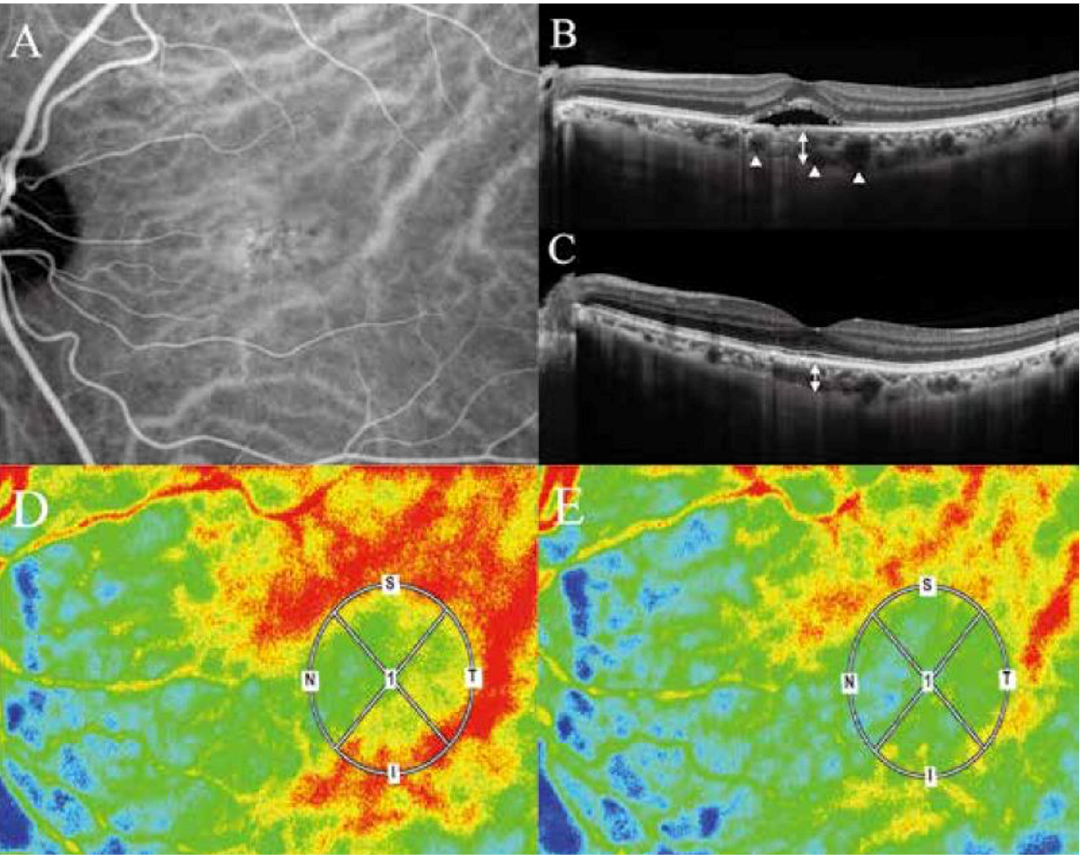
Figure 2. Photographs of an eye with CSC. ( A ). Indocyanine green dye leakage at the macula region shows hyperpermeability of the choriocapillaris. ( B ). CSC, pachychoroid, and pachyveins during the onset. ( C ). Regression of CSC in the same eye. ( D ). LSFG at the onset of CSC. The LSFG shows blood flow velocities in the choroid at the macula region where SRD exists (within the circle) and its surrounding area of the choroid. Note that the velocity in the macula region is much slower (yellow to green) than that in the surrounding area (mostly red), suggesting that there is a drastic decrease of the choroidal blood flow speed in the macula region. ( E ). The choroidal velocities after the regression of SRD. Note that there is a much less difference in the speed between the macula region and its surrounding area. Less difference in the speed means less difference in the blood pressure between the two regions, according to Bernoulli’s theorem, reducing pachyveins. (Adapted from Saito W et al., 2020 [18] and 2021 [19]).